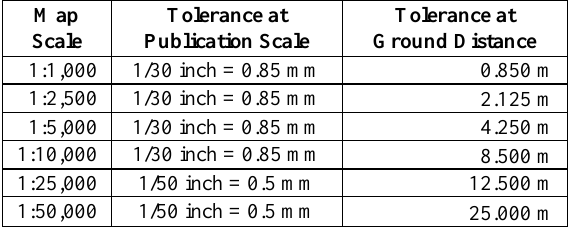
Table 5. NMAS Horizontal Accuracy Tolerance